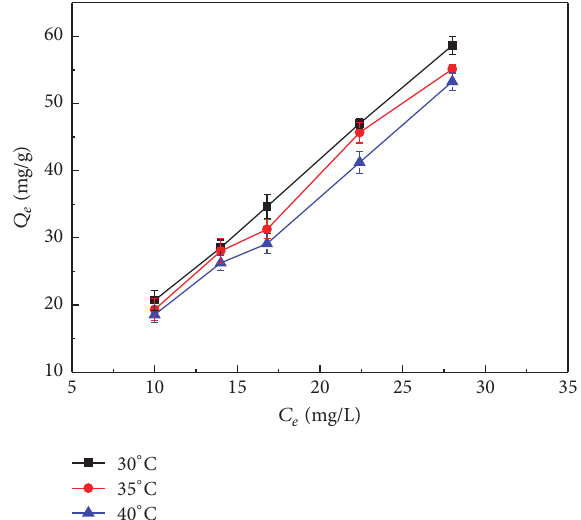
Figure 8: Adsorption isotherm of CA4 for methyl orange at 30 ∘ C, 35 ∘ C, and 40 ∘